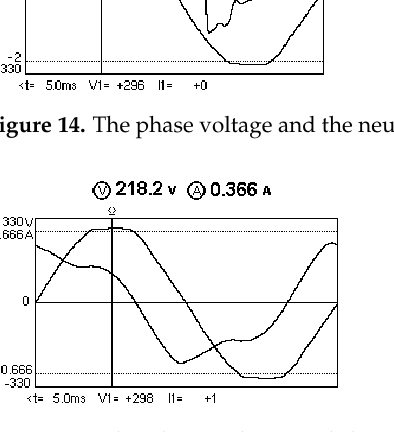
Figure 14. The phase voltage and the neutral current for a compact fluorescent lamp (set 4).